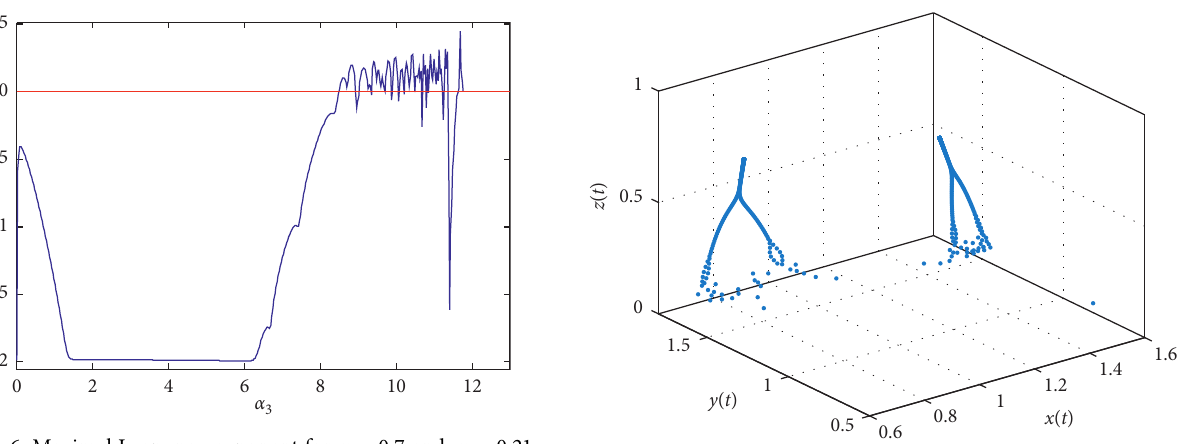
Figure 8: Strange attractors for α